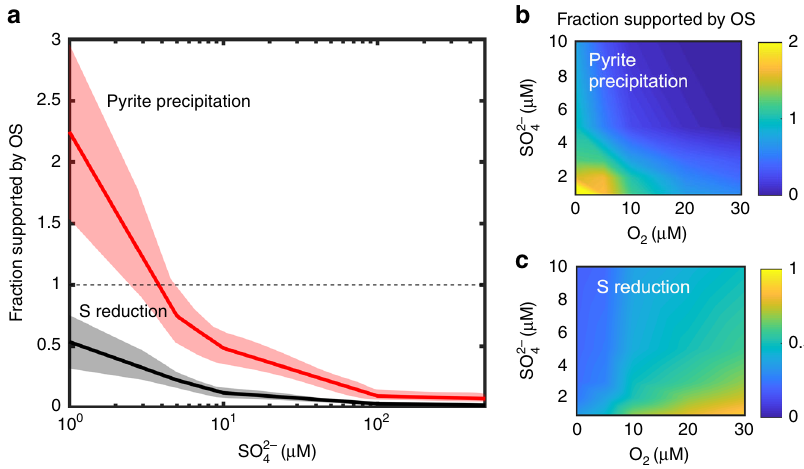
Fig. 2 Contribution of organic sulfur to S reduction and pyrite precipitation. a As a function of sulfate (sul fi te) concentration under anoxic conditions. Shaded bands re fl ect the corresponding ±1 σ ranges obtained in the sensitivity analysis (see Methods section). b , c The same, in presence of oxygen. The fraction of supported S reduction was calculated as the ratio of the depth integrated rates of oxidized OS mineralization and sediment S reduction. The latter was corrected for the fraction of sulfate reduction supported by elemental S disproportionation and sul fi de reoxidation. The fraction of supported pyrite precipitation was calculated as the ratio of the depth integrated rates of reduced OS mineralization and Fe sul fi de precipitation. The ratio was corrected for elemental S disproportionation and the fraction of produced hydrogen sul fi de that becomes unavailable for precipitation because of aerobic oxidation (see Supplement). Values greater than 1 correspond to a situation where excess hydrogen sul fi de diffuses out of the sediment. Sediment was assumed to contain 0.5% of organic carbon by dry weight, with the molar S:C ratio of